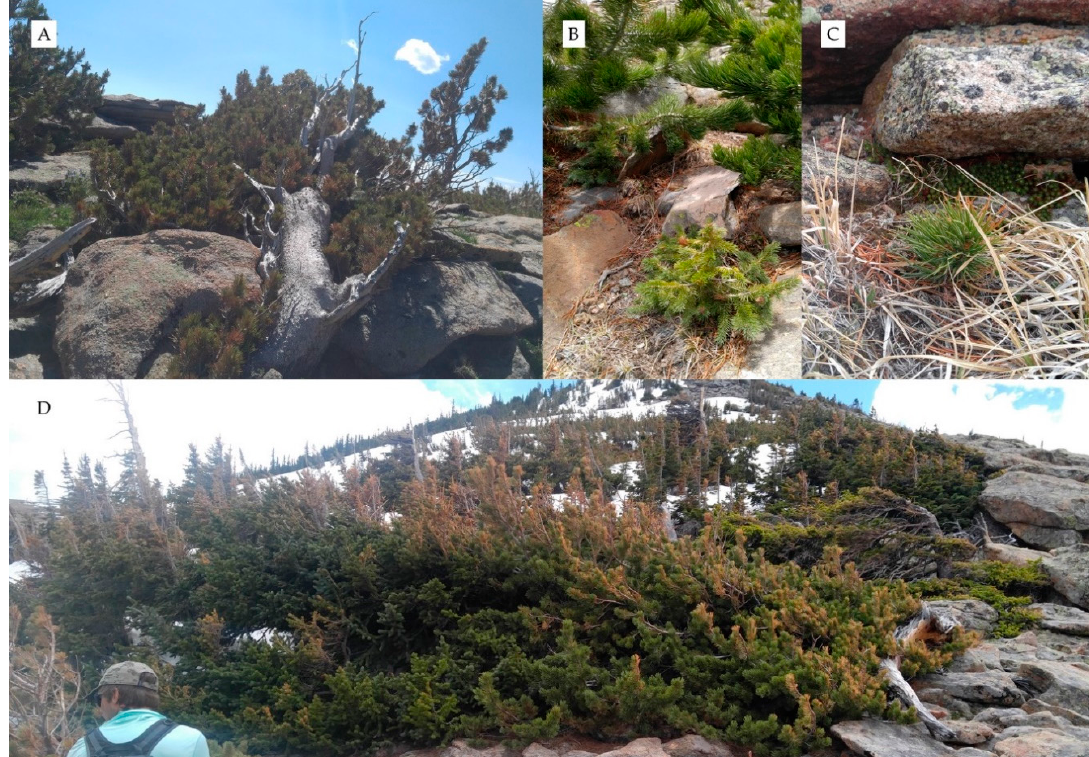
Figure 2. Functional roles of trees in alpine treeline ecotone (ATE) communities with respect to position outside or within tree islands including single-tree islands ( A ), satellite trees ( B ), solitary trees ( C ), multi-tree island component, and multi-tree island initiator ( D ).